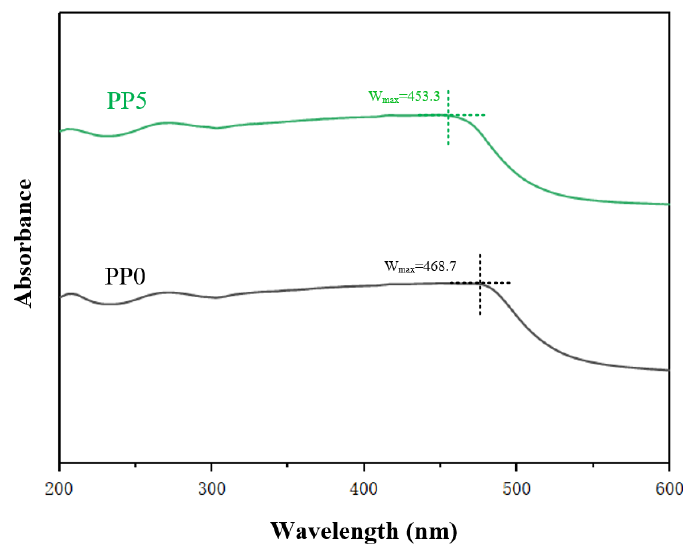
Figure 5. Ultraviolet visible absorption spectrum of films.